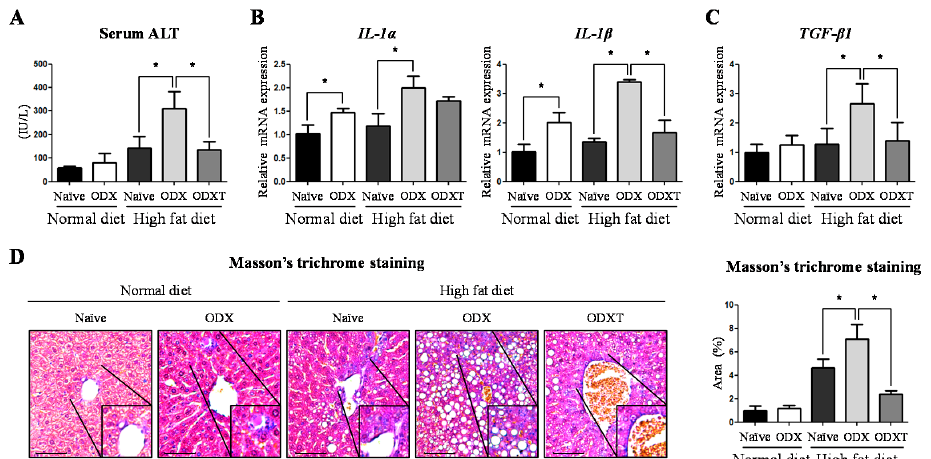
Figure 2. The hepatic steatosis depending on high energy diet and androgens is progressed to steatosis-induced NASH with fibrosis. ( A ) Serum alanine aminotransferase (ALT) was measured as the damage marker of hepatocytes. ( B ) To consider the influence on the inflammatory response, interleukin-1 α ( IL-1 α ) and IL-1 β mRNA levels were determined by quantitative RT-PCR, using mouse 60S acidic ribosomal protein P0 ( mRPLP0 ) as an internal control. ( C ) As a marker of fibrosis, transforming growth factor- β ( TGF- β ) mRNA levels were determined by quantitative RT-PCR, using mRPLP0 as an internal control. ( D ) To show the development of fibrosis in livers, Masson’s trichrome staining was performed and the fibrotic areas were quantified by image J program. Scale bar = 100 µm. The values stand for means +/ − S.D. * p < 0.05 was compared to groups indicated.